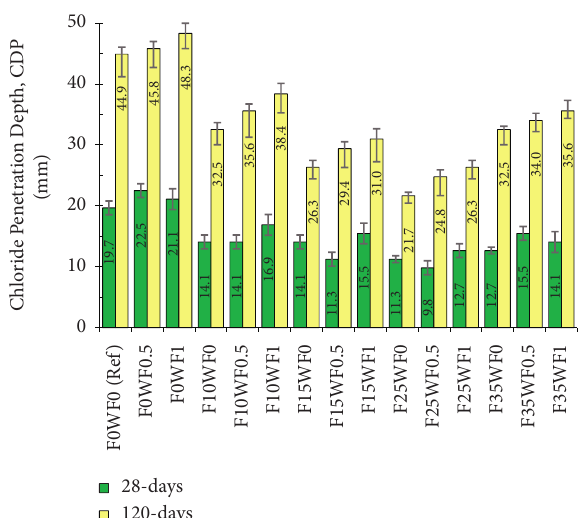
Figure 20: CPD of each HSC mix with different incorporation levels of FA and WSF.